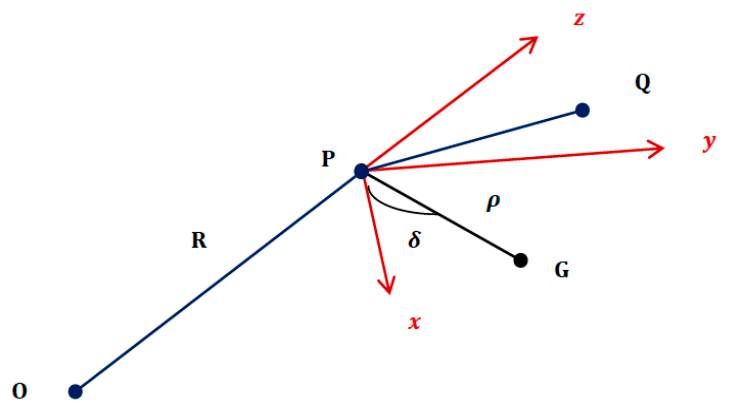
Figure 2. The particle, at rest, released from Q in the local Cartesian frame ( x , y , z ) hits the xy - plane at a point G . The angle between PG and the x -axis is denoted δ .